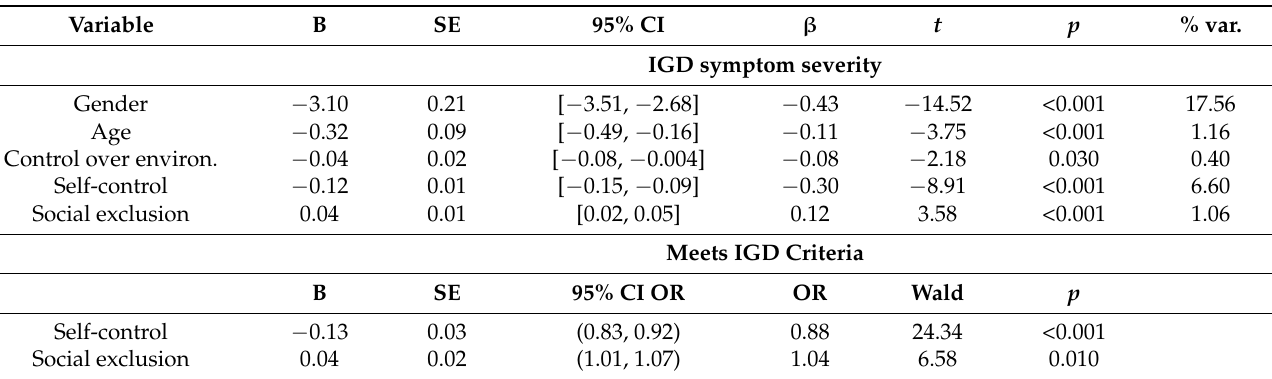
Table 3. Regression models predicting IGD symptom severity and meeting IGD criteria using backward